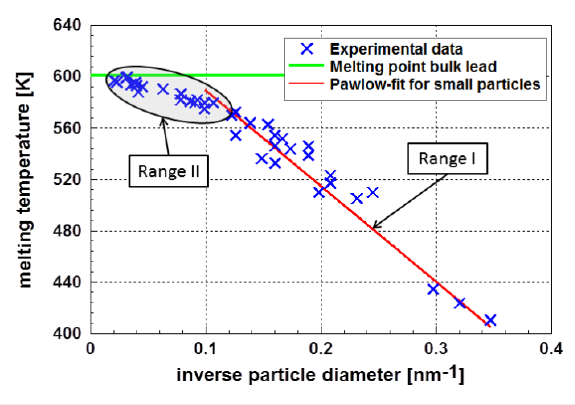
Figure 11: Melting temperature of lead according to Coombes [16]. This figure shows two ranges of melting temperatures dependent on the particle diameter. Range I follows the Pawlow relation; in this range the particles melt as a whole. In Range II the melting starts at the sur- face of the